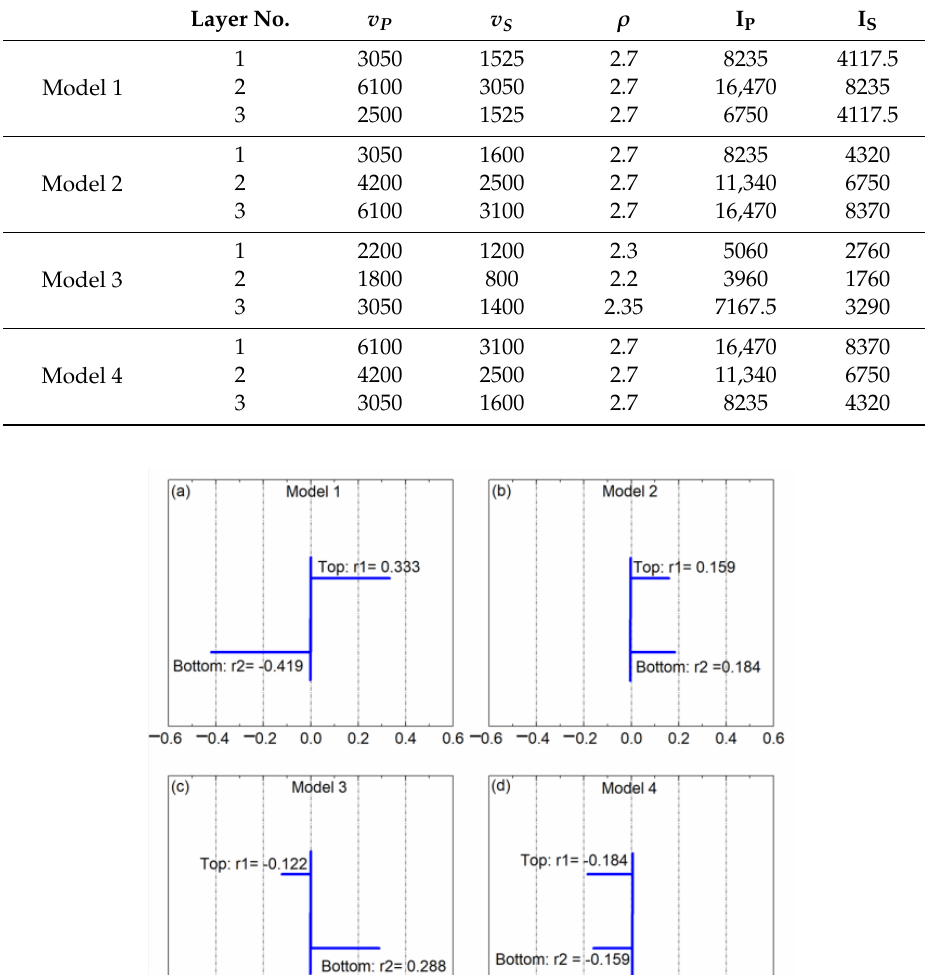
Table 1. Parameters of thin-bed models. I P and I S are P-wave and S-wave impedances, respectively, units of velocities and densities in Table 1 are m/s and g/cm 3 , respectively. Layer No.